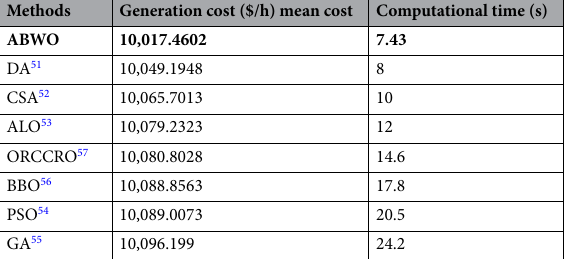
Table 5. Performance analysis of ABWO comparing other approaches for case study-I. Significant values are in bold.